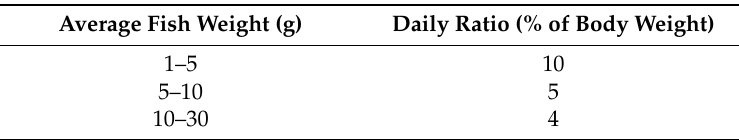
Table 5. Feed application rate according to the weight of